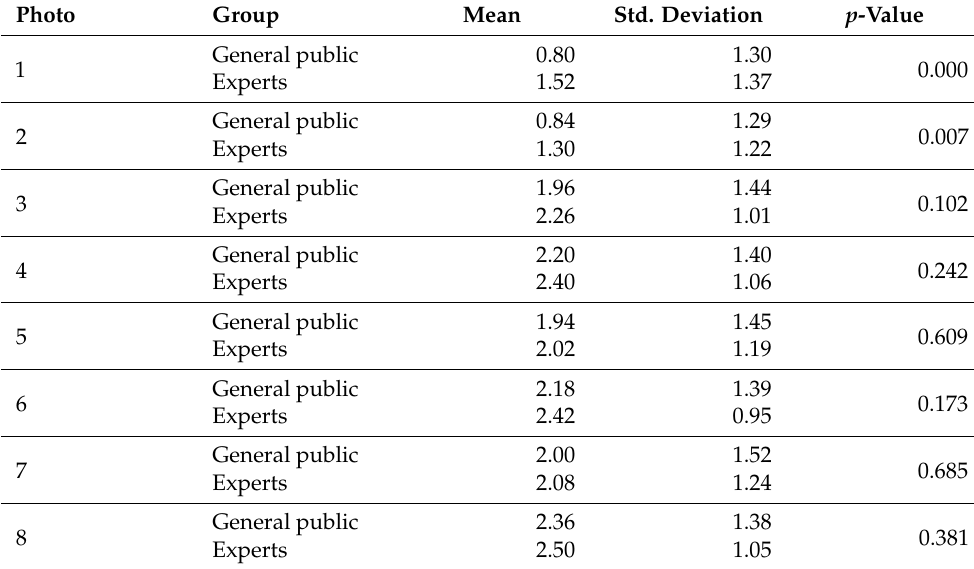
Table 13. Evaluation of creation of sound by experts and the public.